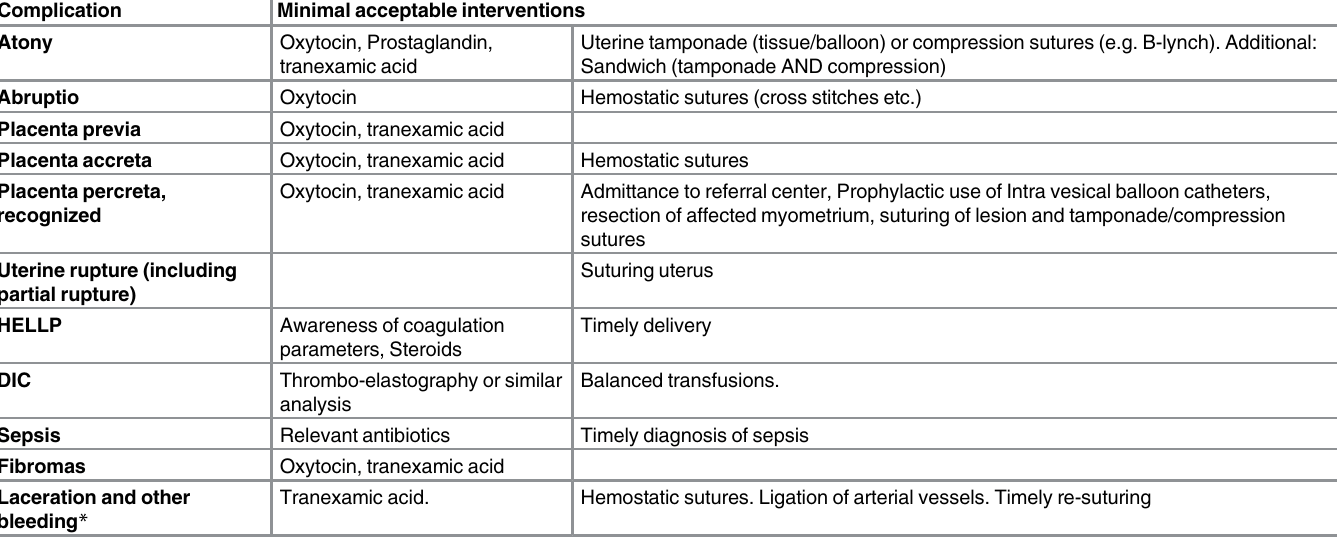
Table 2. Criteria for minimal acceptable medical and surgical